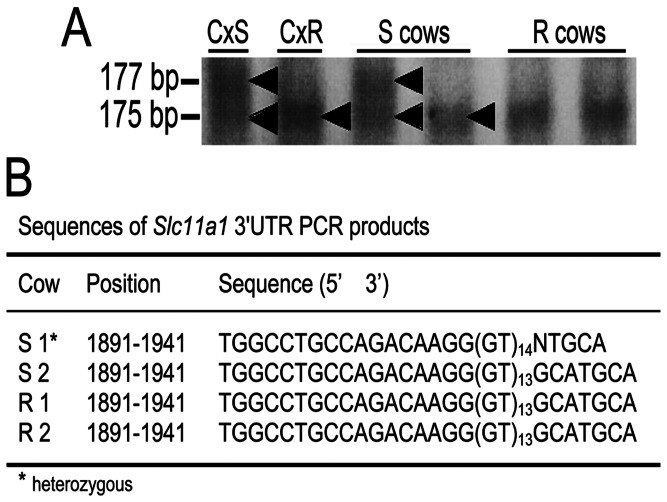
3′ UTR SLC11A1 gene polymorphism analysis in resistant and susceptible macrophages.Representative results from resistant (R) and susceptible (S) cattle genomic DNA single-stranded conformational analysis (SSCA) indicating the homozygous GT13 (175 bp) and heterozygous GT13/GT14 (177 bp) alleles. DNA from cattle genetically characterized as susceptible (SLC11A1s) or resistant (SLC11A1r) to standardized Brucella abortus in vivo challenge were used as controls (Cx) (A). DNA sequencing of PCR amplicons of SLC11A1 3′UTR confirmed the SSCA results evidencing the only one heterozygous genotype among all phenotyped susceptible and resistant cattle to BCG (B).